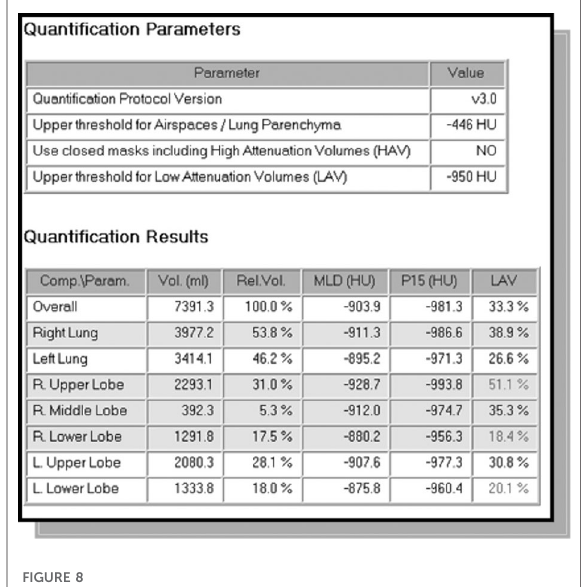
FIGURE 8 Lobe based functional CT parameters.